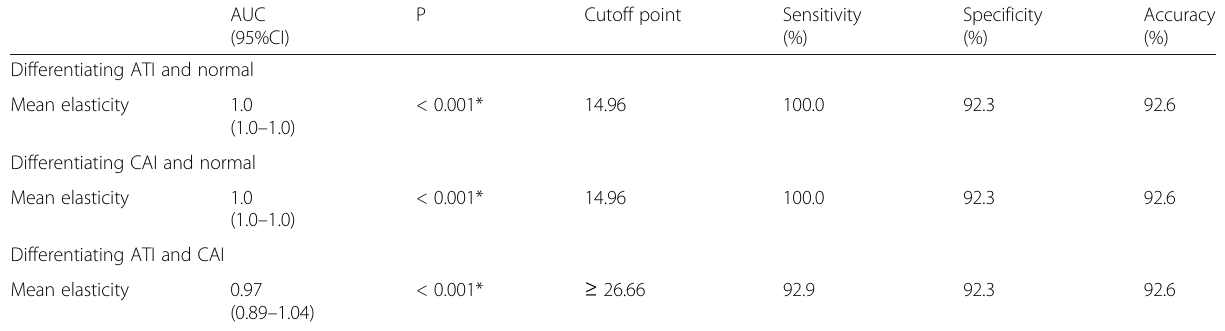
Table 4 Statistic of the means elasticity values between the 3 groups AUC (95%CI)